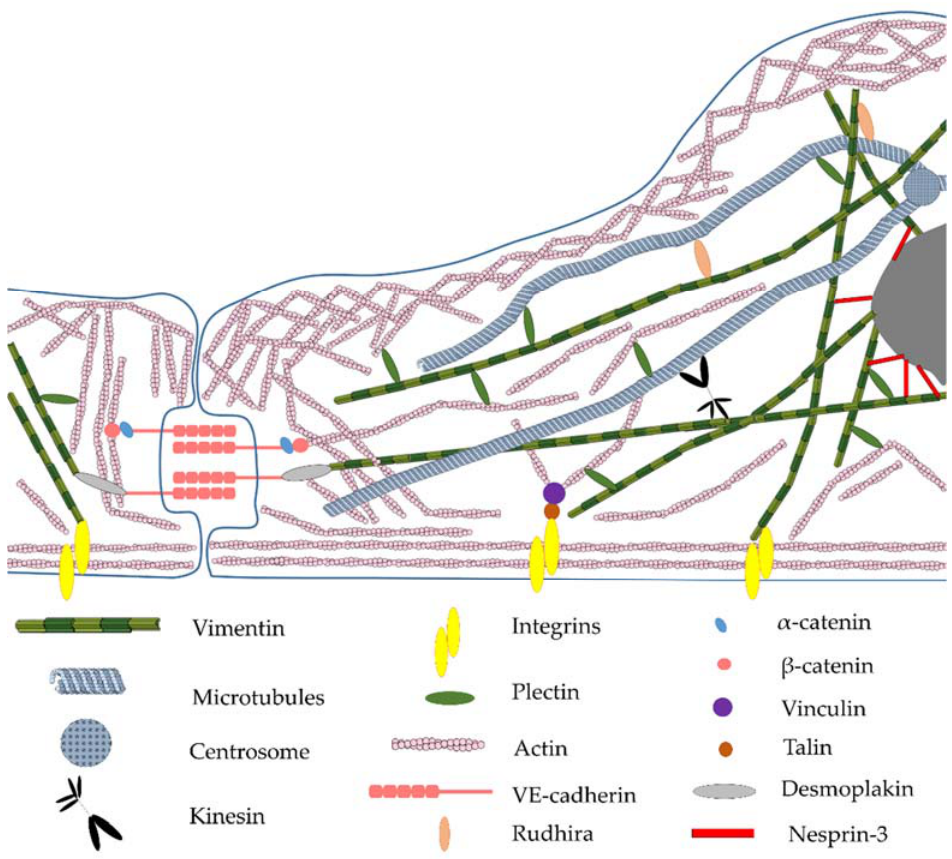
Figure 1. Scheme of interconnection of vimentin and other cytoskeleton components and endothelial cell proteins.